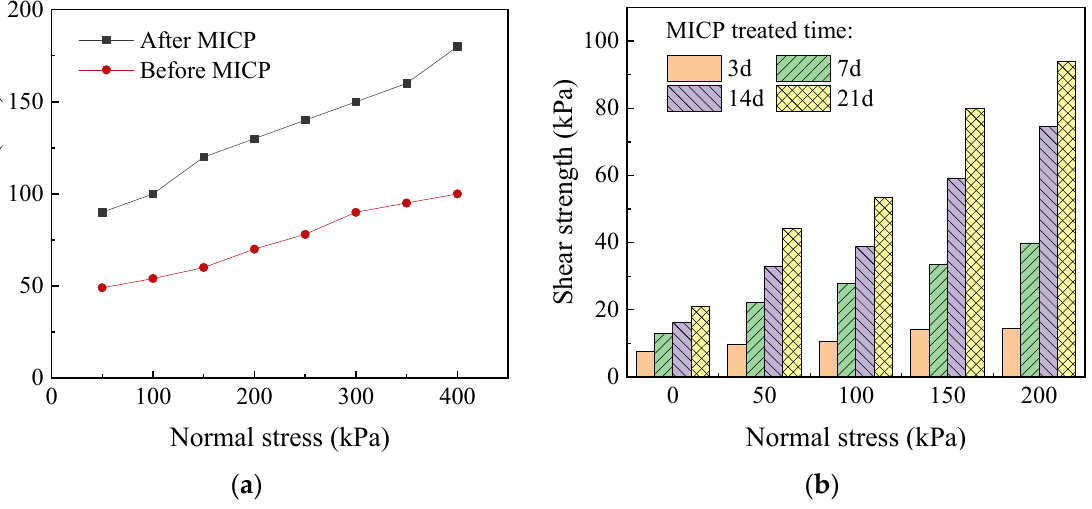
Figure 9. Curves of shear strength for ( a ) comparison between MICP-treated and untreated expansive soils; ( b ) different MICP-treated days.